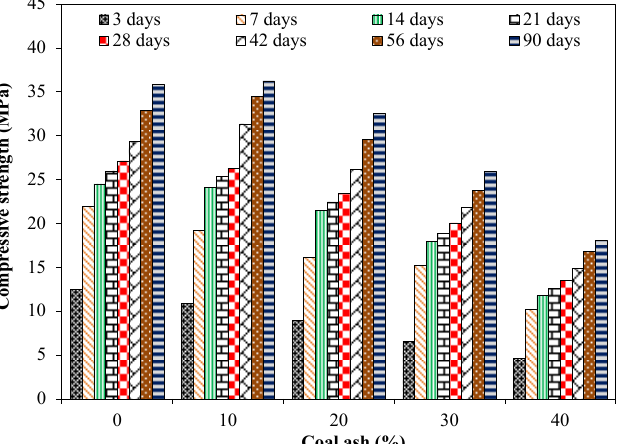
Figure 6. Compressive strength results for specimens incorporating various dosages of CA placed in normal water.